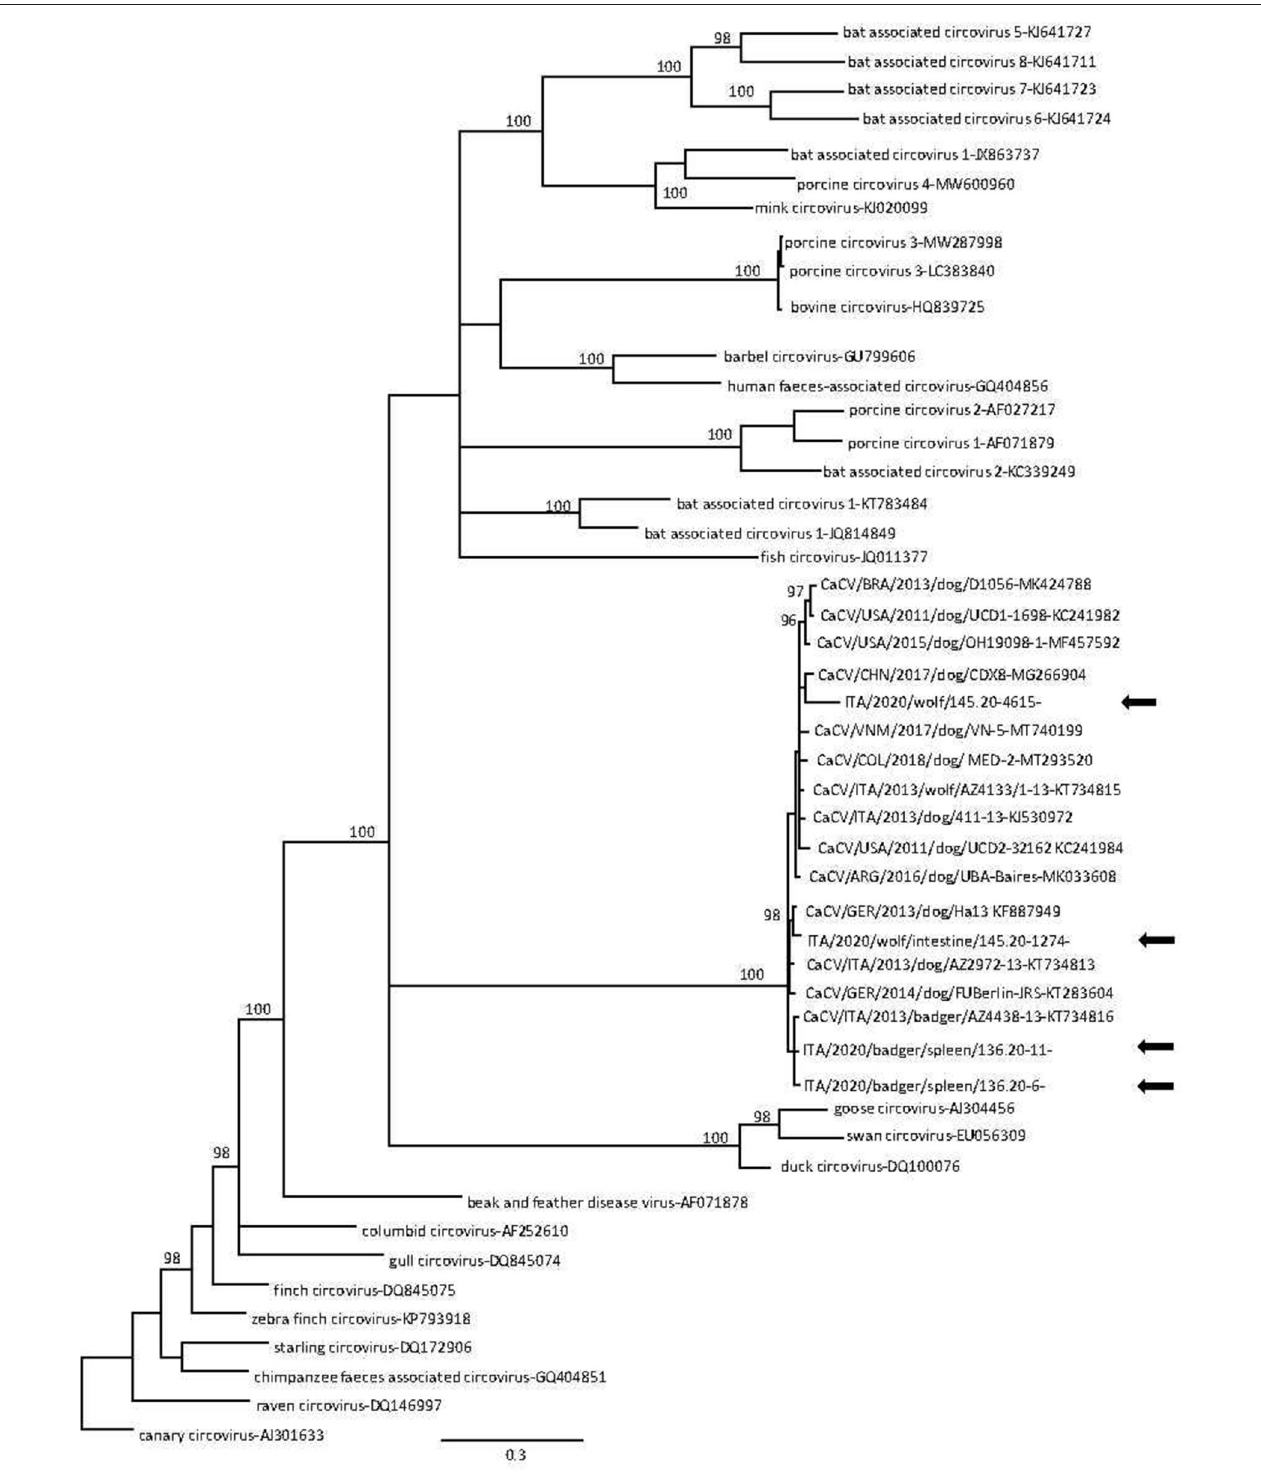
FIGURE 2 | Phylogenetic tree based on alignment of the partial replicase gene (417 nt) of canine circovirus (CanineCV) sequences detected in this study and other circoviruses retrieved from the GenBank database. Canary circovirus (GenBank accession no. AJ301633) was used as outgroup. Posterior output of the tree was derived from Bayesian inference using 4 chains run for > 1 million generations, 2-character states (Hasegawa–Kishino–Yano) model, a proportion of invariable sites and a subsampling frequency of 1,000. Posterior probability values > 95 are indicated on the tree nodes. The black arrows indicate the sequences identified in this study. Scale bar indicates nucleotide substitutions per